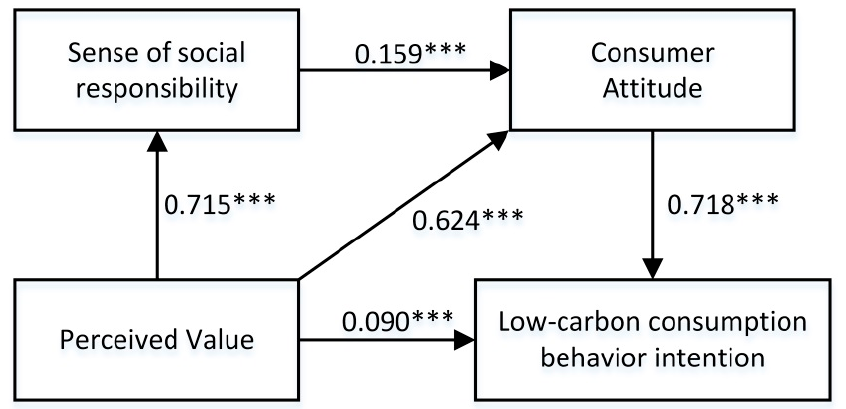
Figure 2. Direct effect model diagram of tourists’ low-carbon consumption behavior intention. PS: *** means p < 0.001.